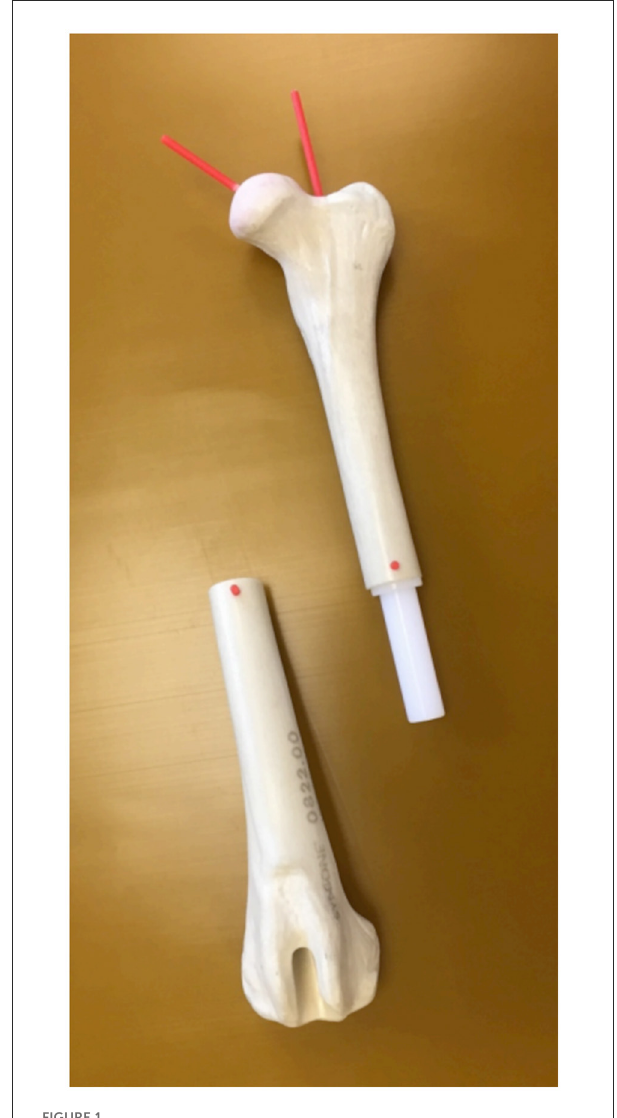
FIGURE1 Torsional deformity model. An anatomical femoral bone model of a normal canine femur (Synbone ® , Malans, Switzerland) with a mid-diaphyseal rotational hinge enabled free twisting of both segments about the femoral longitudinal